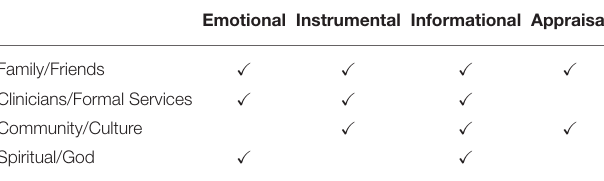
TABLE 4 | Intersection of social support sources and